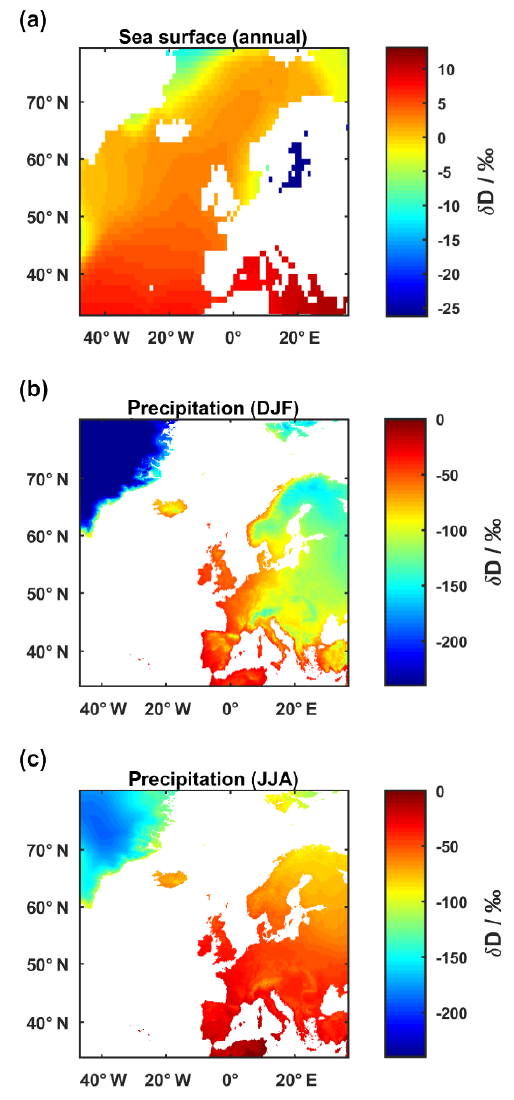
Figure 1. (a) δ D of ocean surface water derived from the inter- polation (V1.1) of the Global Seawater Oxygen-18 Database by LeGrande and Schmidt (2006), assuming a constant factor of 6.56 between δ D and δ 18 O in ocean surface water. (b) Climatological δ D in precipitation in winter (DJF) from the Regionalized Cluster- based Water Isotope Prediction (RCWIP), which in turn is based on observations of the Global Network of Isotopes in Precipitation (GNIP). (c) Same as in (b) but for summer (JJA).